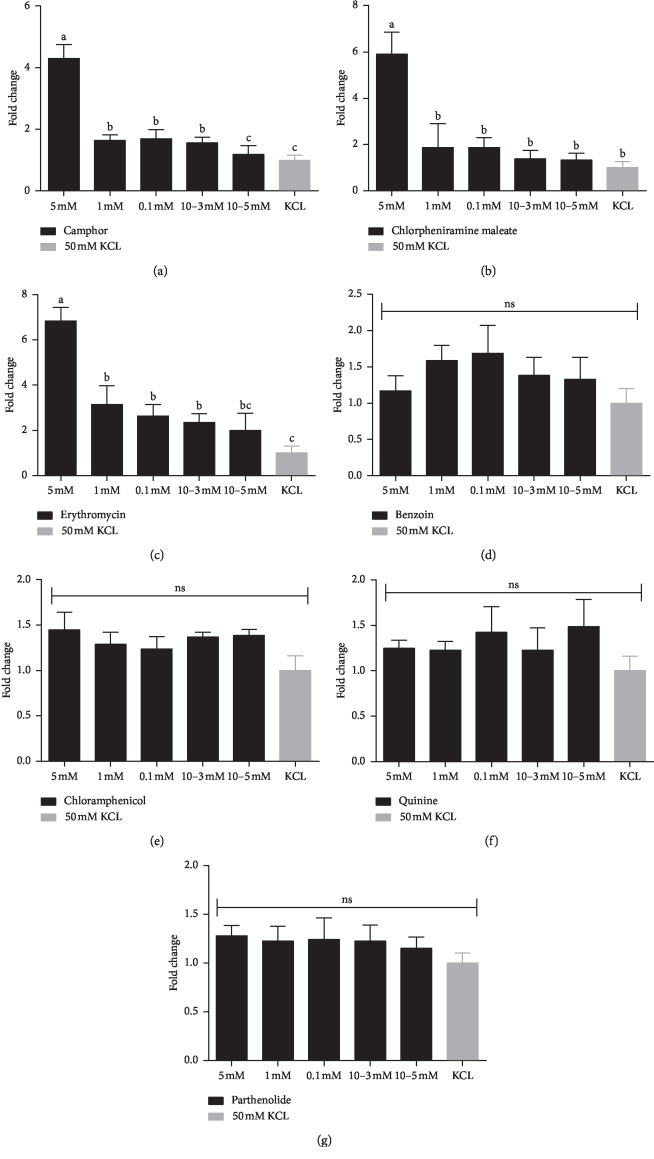
Relative expression levels of T2R7 mRNA in tongue tissue of chicken stimulated by different concentrations of (a) camphor, (b) chlorpheniramine maleate, (c) erythromycin, (d) benzoin, (e) chloramphenicol, (f) quinine, and (g) parthenolide, as determined by real-time PCR. The relative gene expression was measured by qPCR and normalized to GAPDH, and a 50 mM KCL solution was the negative control. Each bar represents the mean ± SE of the results from 2 to 3 independent experiments performed in triplicate. Different small letters on the bar indicate significant differences at P < 0.05.